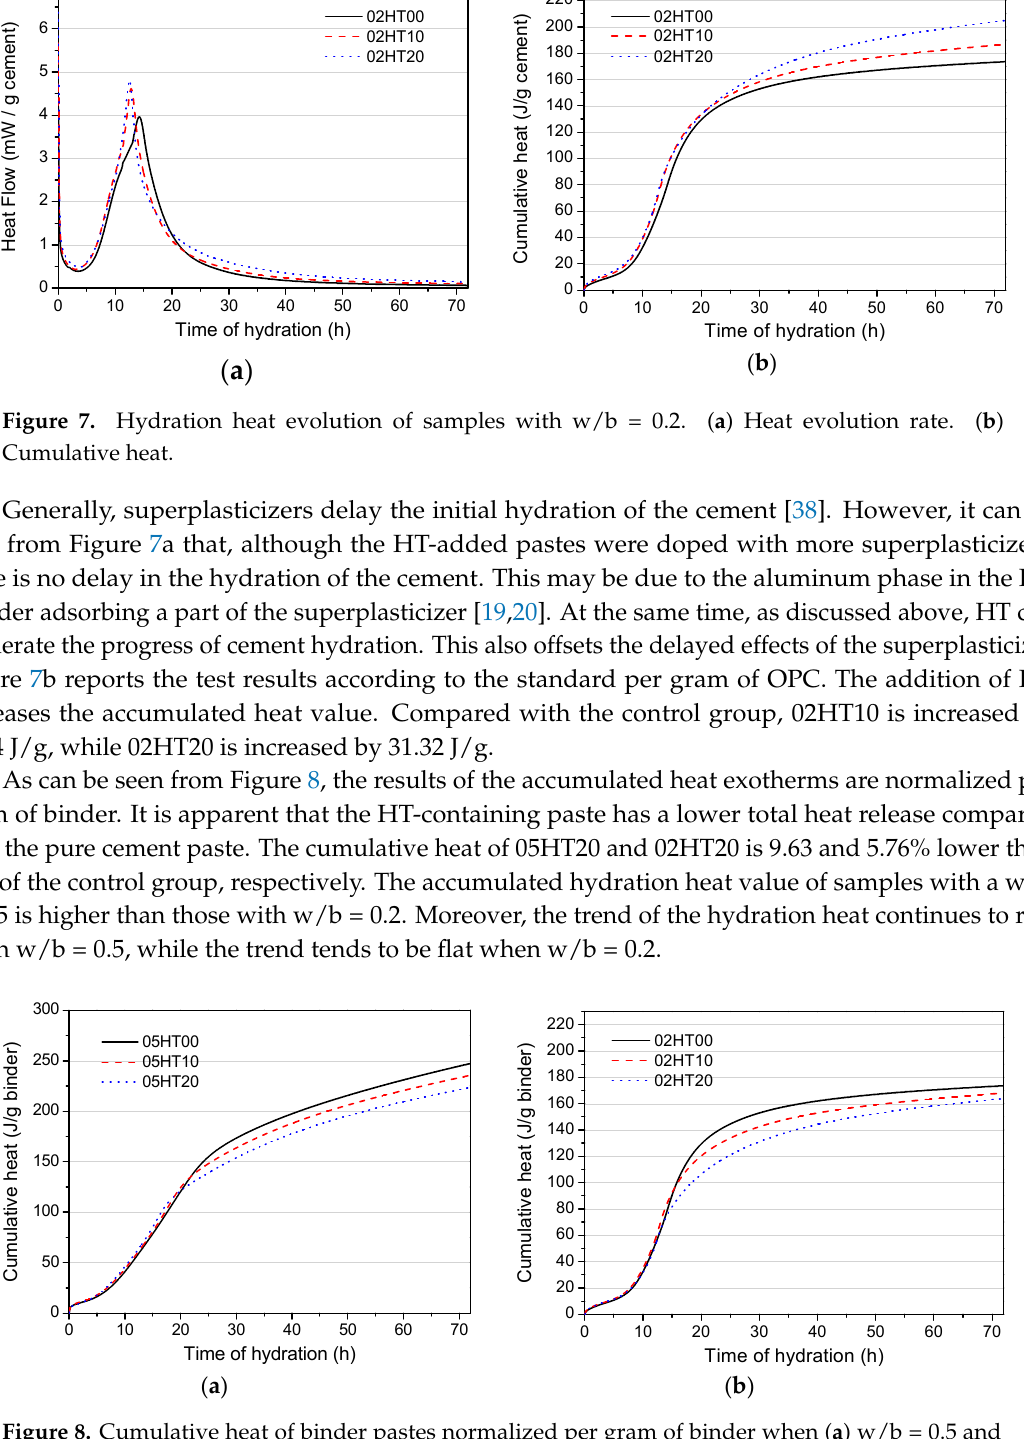
Table 3. Al 3+ ion concentration after one day. Figure 8. Cumulative heat of binder pastes normalized per gram of binder when ( a ) w/b = 0.5 and ( b ) w/b = 0.2.